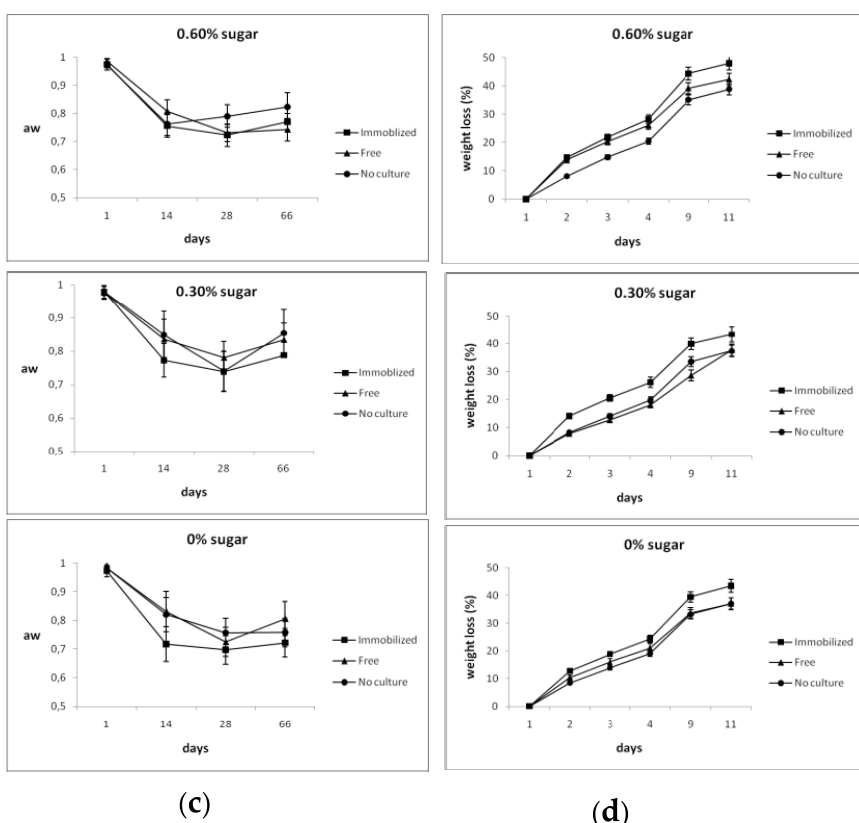
Figure 1. Effect of probiotic starter culture and sugar content on physicochemical parameters during ripening of probiotic dry-fermented sausages: ( a ) pH, ( b ) titratable acidity, ( c ) water activity (Aw) and ( d ) % weight loss. Error bars indicate standard deviations ( n = 3).